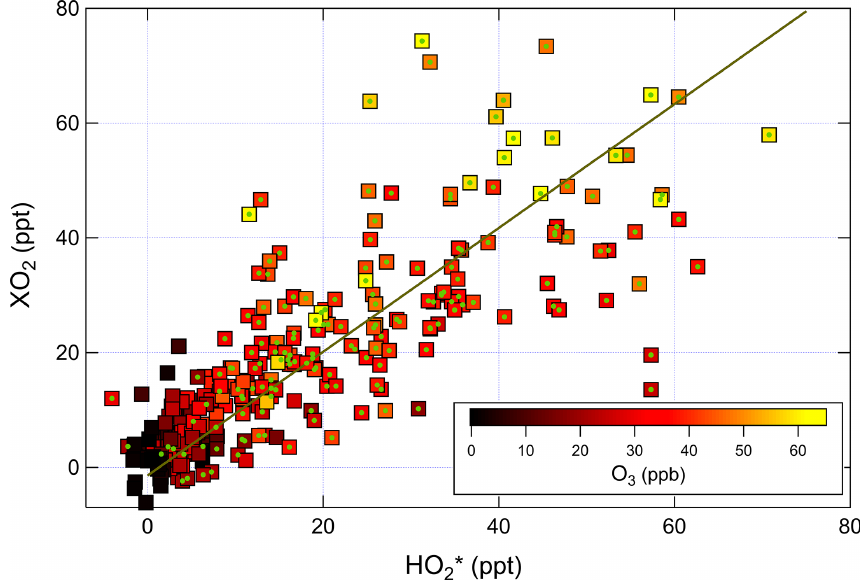
Figure 6. Correlation of ambient [XO 2 ] measured by ECHAMP with [HO ∗ 09:00 and 22:00, indicated by the points with green circles. The equation of the fit is [ XO 2 ] = ( 1 . 08 ± 0 . 05 ) [ HO ∗